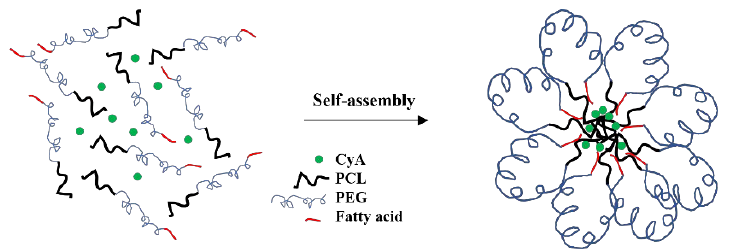
Figure 7. Proposed model for Myrj- b -PCL micelle formation in water.